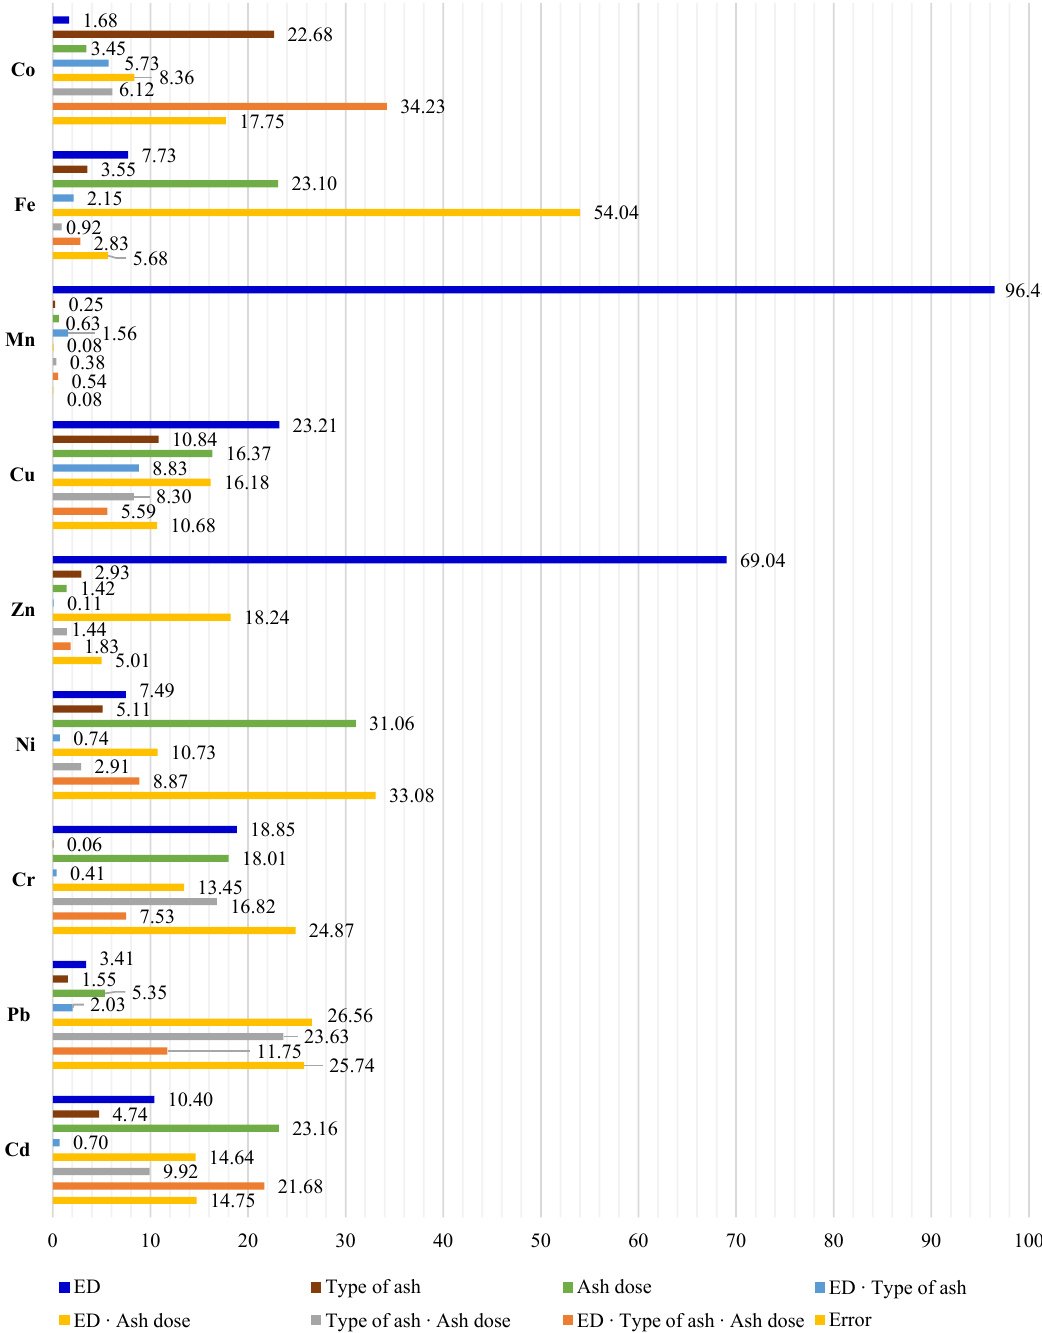
Figure 2. Percent contribution of tested factors according to the content of trace elements in above- ground parts of maize ( Zea mays L . ): ED—Eco-Diesel oil dose.